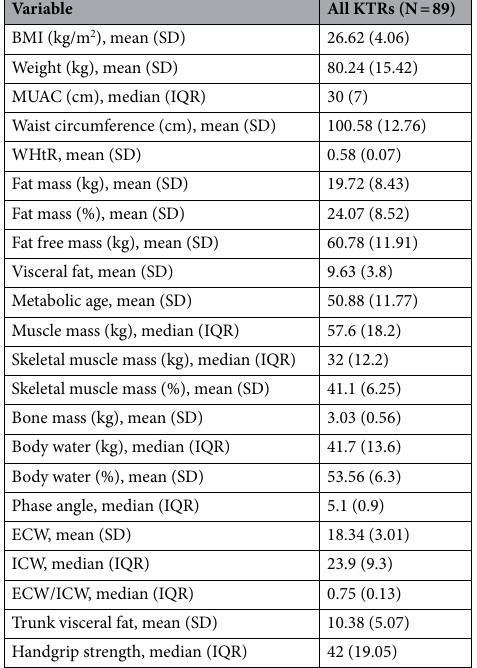
Table 1. Basic characteristics of study participants regarding anthropometric and body composition parameters. BMI body mass index, MUAC middle upper arm circumference, WHtR waist-to-height ratio, ECW extra cellular water, ICW intra cellular water.